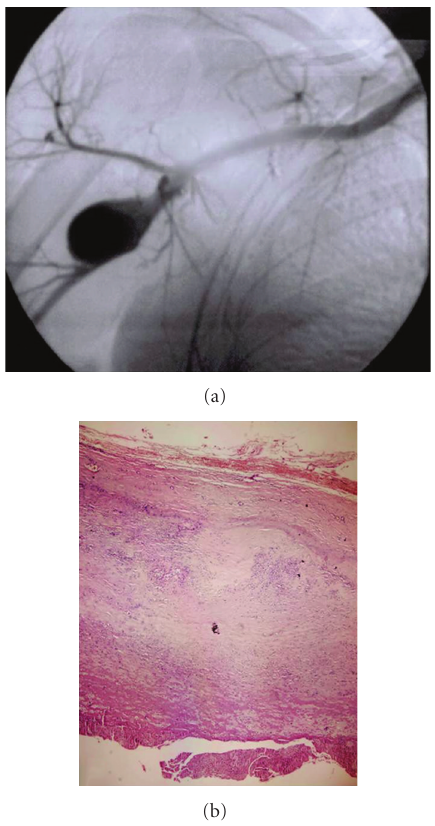
Figure 1: Digital subtraction angiography confirmed an aneurysm at the distal part of right axillary artery (a). In the presented case, pathologic examination of aneurismal sac revealed that all three layers of the arterial wall were intact despite various degrees of degeneration and fibrosis in the media layer (b). H&Ex100.